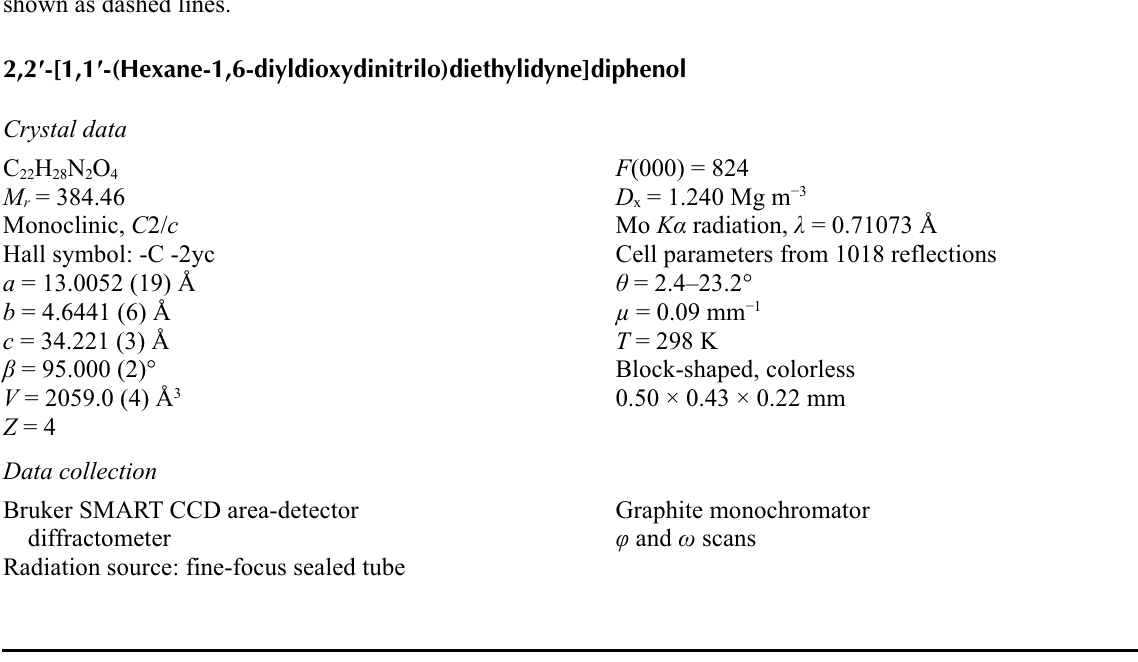
Three-dimensional packing diagram of the title compound along the b axis. Intra- and intermolecular hydrogen bonds are shown as dashed